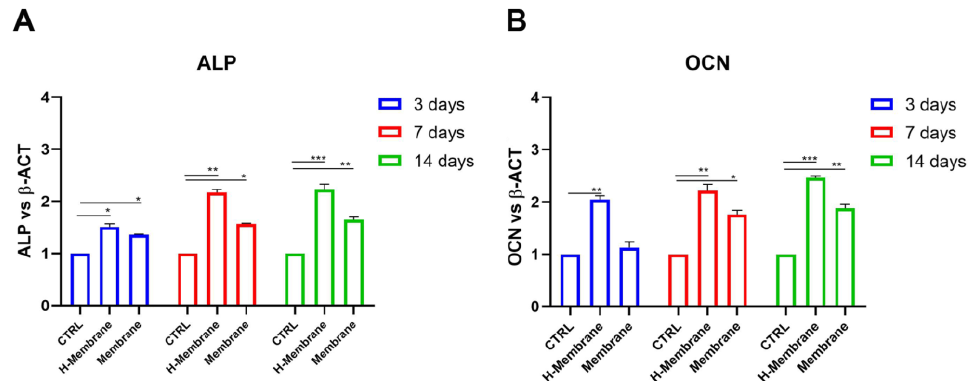
Figure 10. Real-time PCR of osteoblasts (HOBs) seeded on H-Membrane and Membrane for genes encoding Alkaline Phosphatase (ALP) ( A ) and Osteocalcin (OCN) ( B ) at 3, 7, and 14 days post-seeding (* p < 0.05; ** p < 0.001; *** p < 0.0001). ALP and OCN were more expressed in H-Membrane than in Membrane.